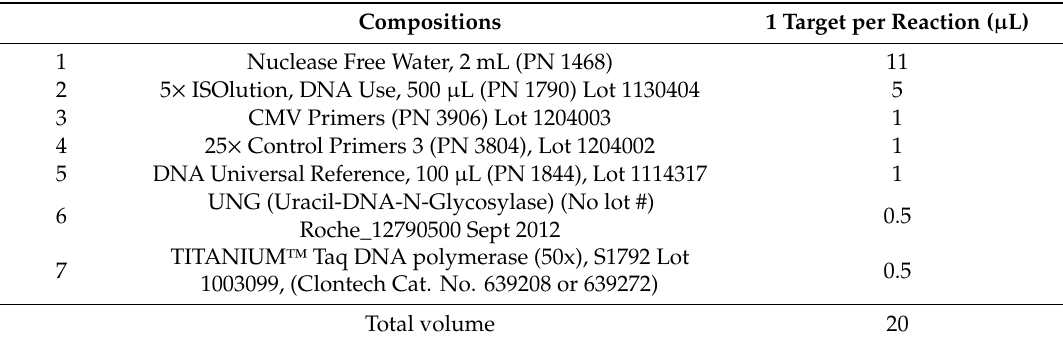
Table 1. MultiCode-RTx qPCR DNA reagent master mix.